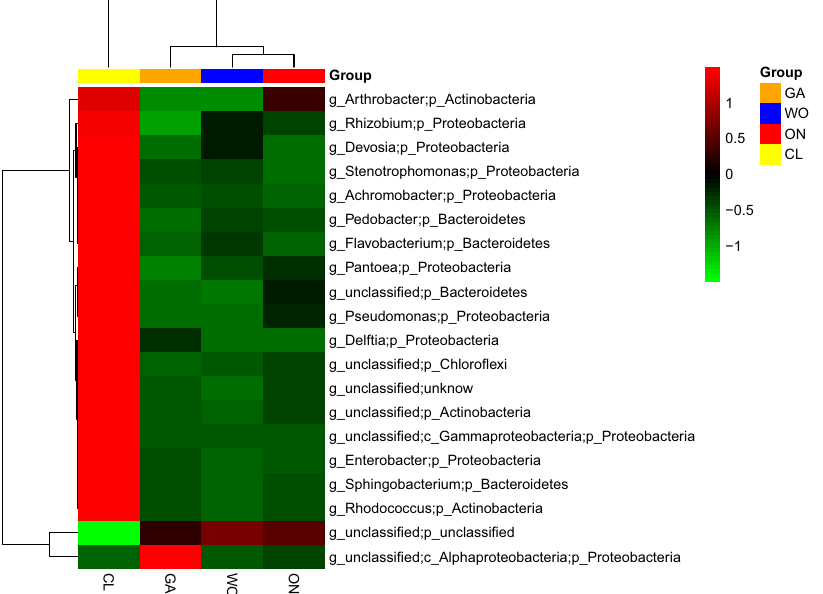
Figure 4. The heatmap displaying the relative abundances of the most dominant genera (top 20, accounting for more than 1.0% total abundance). CL: Chinese leek; WO: Welsh onion; GA: Garlic; ON: